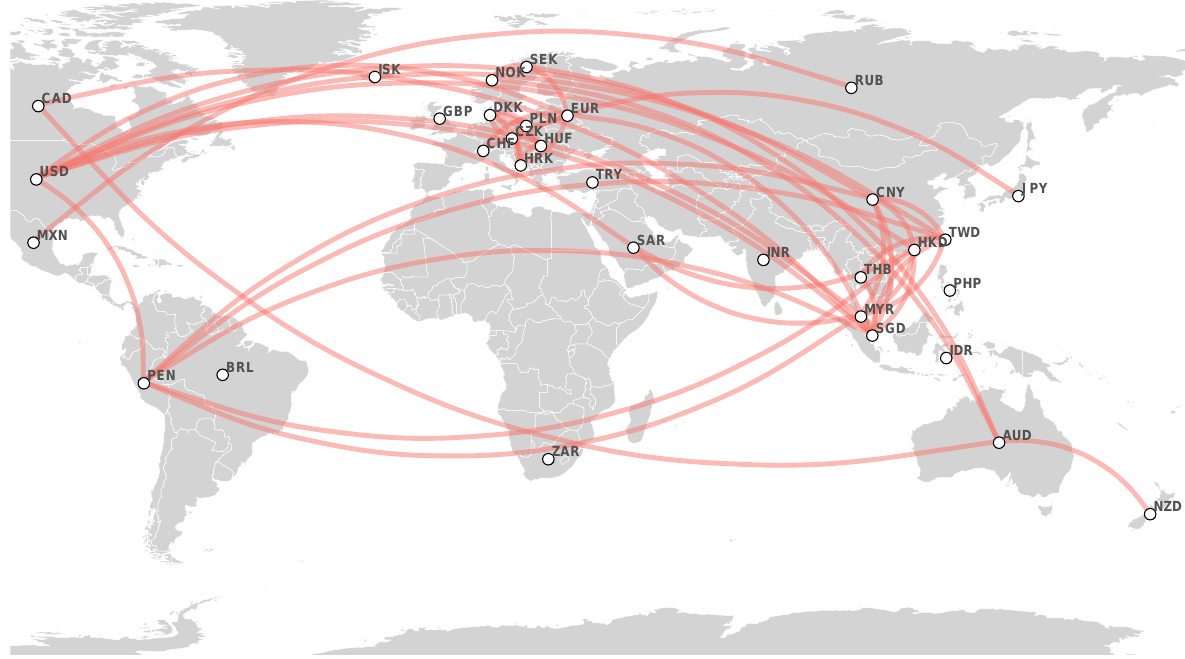
gray Figure 7. Estimated currency network based on 2019 foreign exchange markets